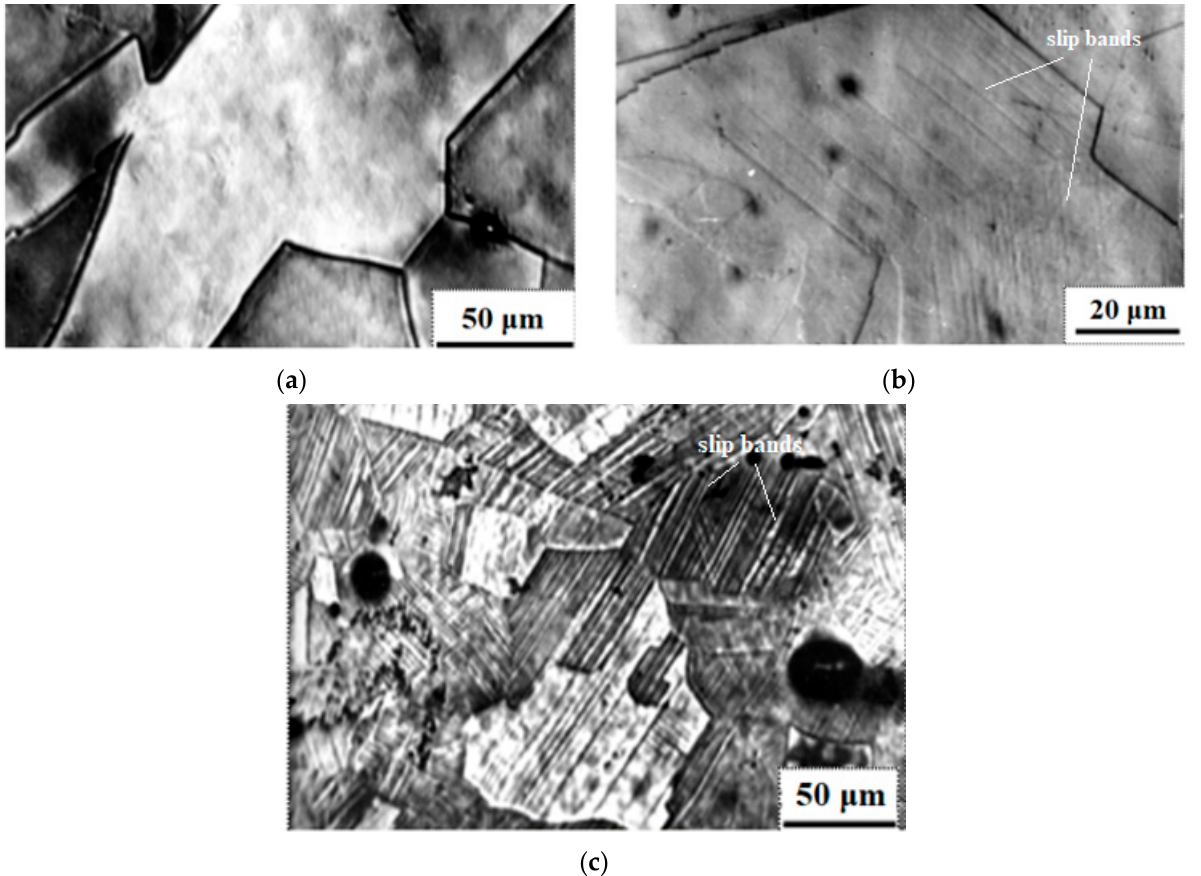
Figure 2. Images of the microstructure of steel after hardening ( a ), tensile 5% ( b ) and 20% ( c ) deformation.